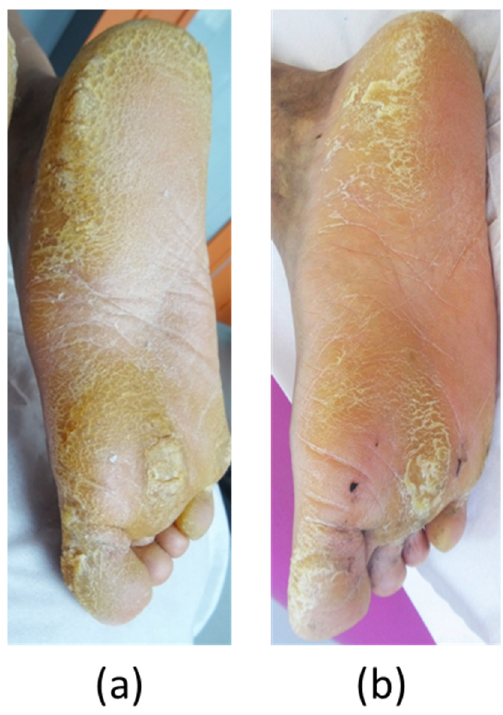
Figure 4. Evolution of plantar keratoderma in patient #2. ( a ) Skin lesions in patient #2 on day 0 before oral erlotinib initiation (3 February 2020). ( b ) Hyperkeratosis reduction after 11 months of treatment (3 January 2021).